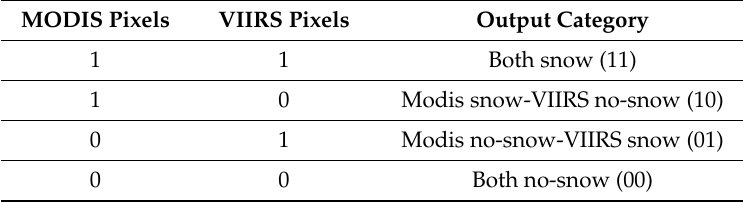
Table 1. Decision rules based pixel classification with coded